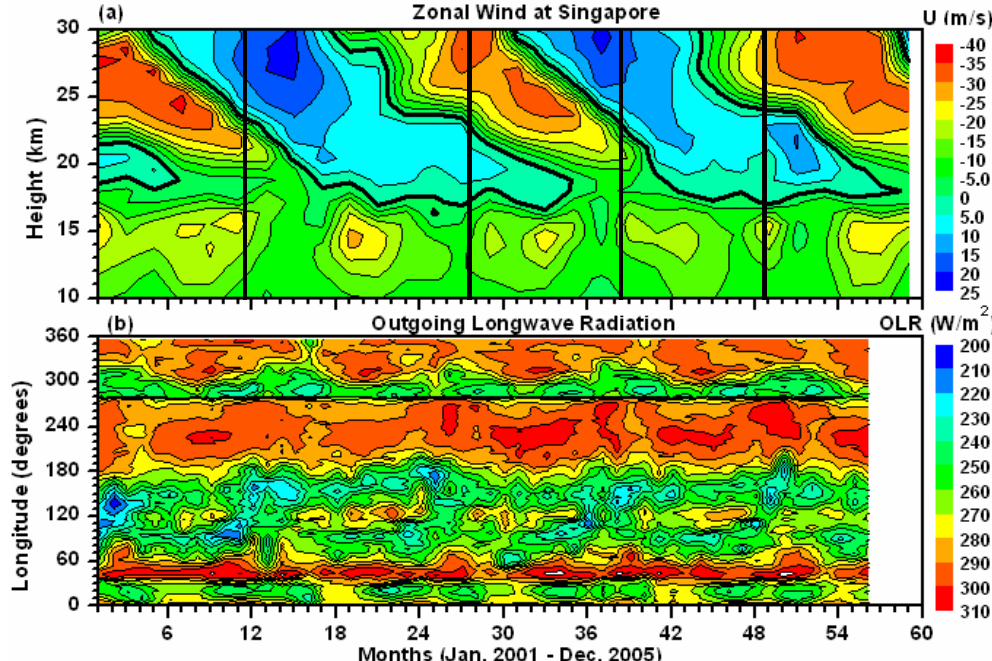
Fig. 1. Height-time cross section of (a) monthly mean zonal wind (m/s) observed during January 2001 to November 2005 at Singapore. The vertical lines show the times of different phases of QBO considered for further analysis. (b) Longitude-time section of outgoing long-wave radiation (W/m 2 ) observed during January 2001 to August 2005. Blue regions (low OLR values) correspond to an area of deep convection.